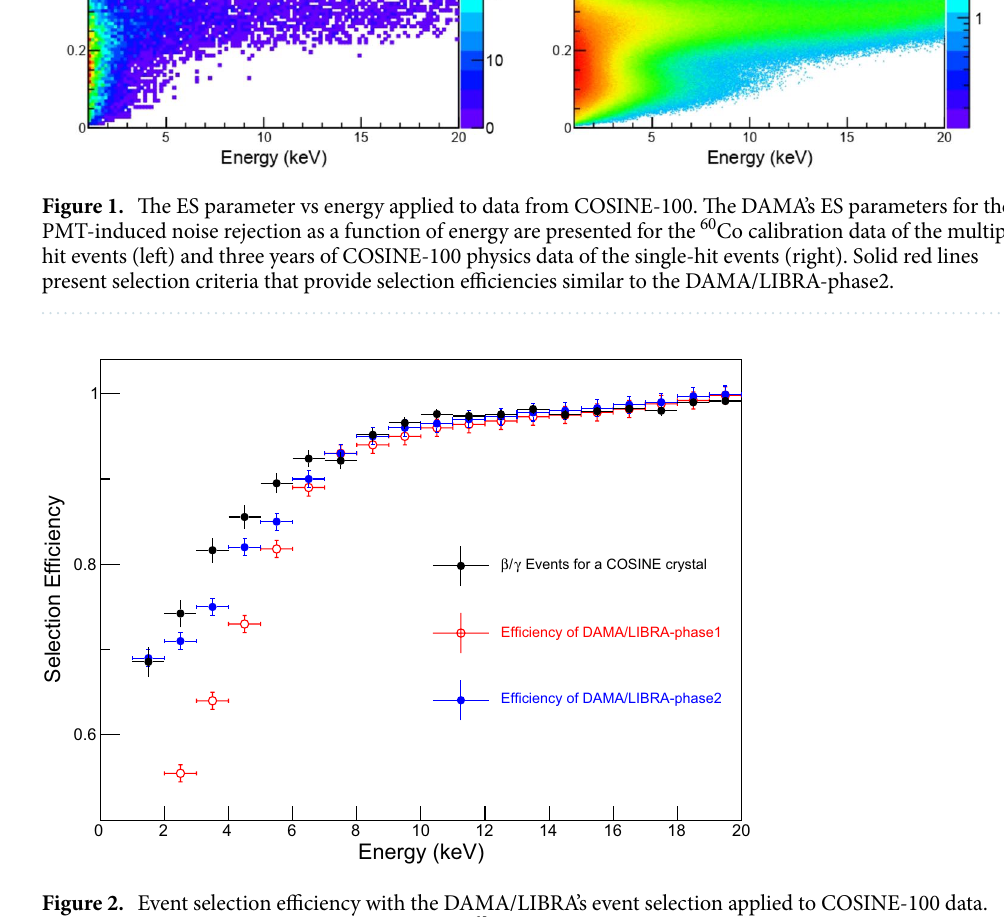
Figure 2. Event selection efficiency with the DAMA/LIBRA’s event selection applied to COSINE-100 data. 60 Event selection efficiencies determined from the Co calibration data using the multiple-hit events of the COSINE-100 crystal (crystal 6) (black points) are compared with those of DAMA/LIBRA-phase1 (red points) 24 and DAMA/LIBRA-phase2 (blue points) 25 . Here selection criteria shown in Fig. 1 are determined to provide efficiencies similar to the